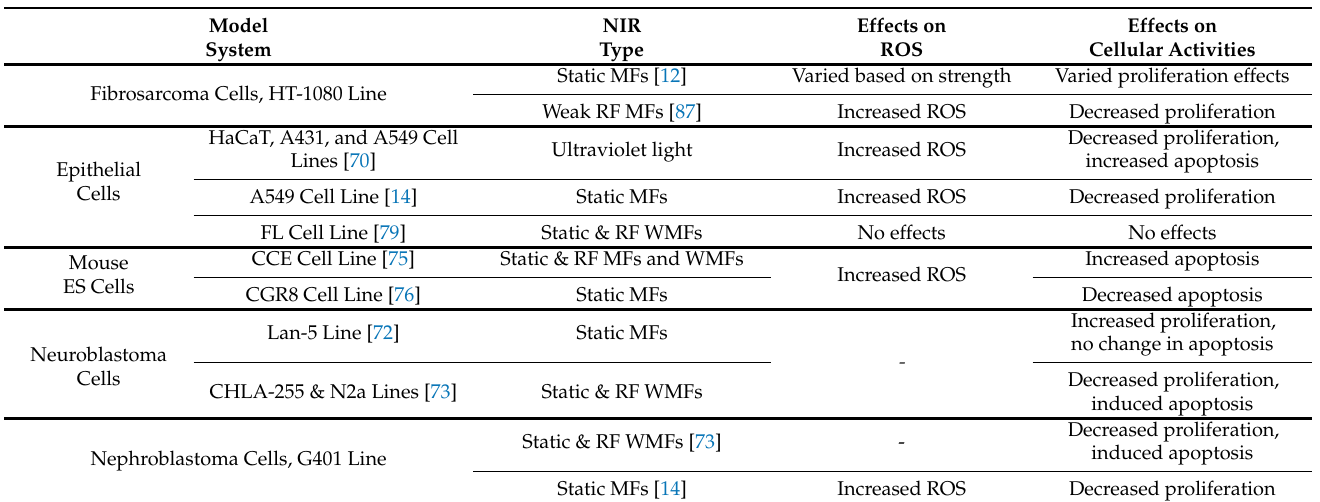
Table 2. List of non-ionizing radiation (NIR) studies and effects on reactive oxygen species (ROS) and cellular processes. This list includes only those studies referenced in this review and is not meant to be comprehensive. WMFs: weak magnetic fields. MFs: magnetic fields. RF: radiofrequency. EMF: electromagnetic fields. ES: embryonic stem